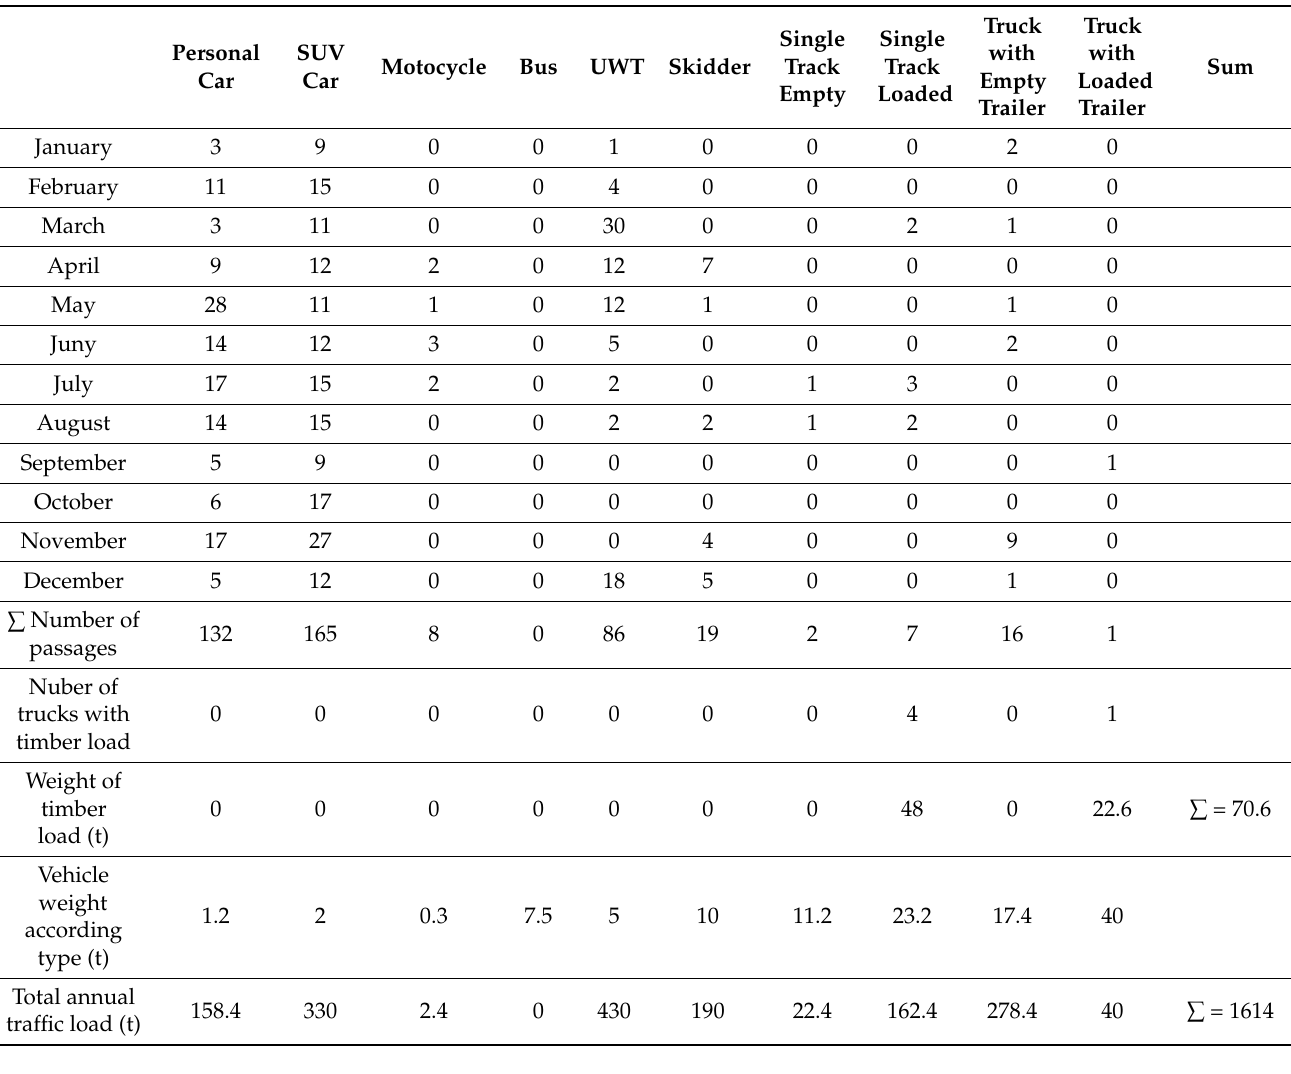
Table 6. Traffic load at B locality in the year 2020.